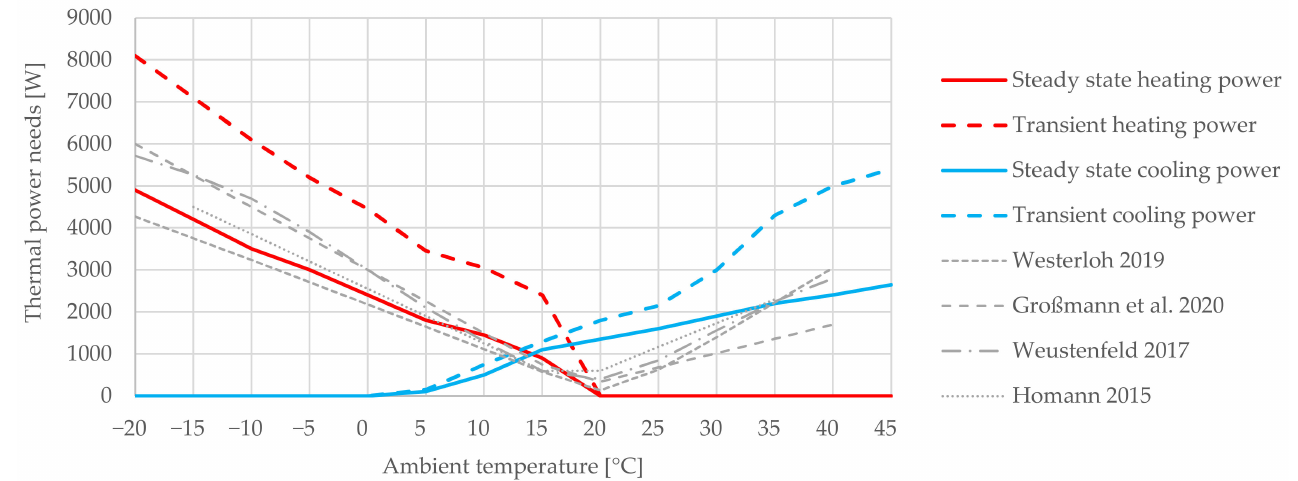
Figure 2. Used heating power needs are shown in red lines and used cooling power needs in blue lines for a mid-sized passenger car based on a cabin thermal model developed by Mansour et al. [19]. They are displayed in comparison to other studies with steady state power numbers from Westerloh